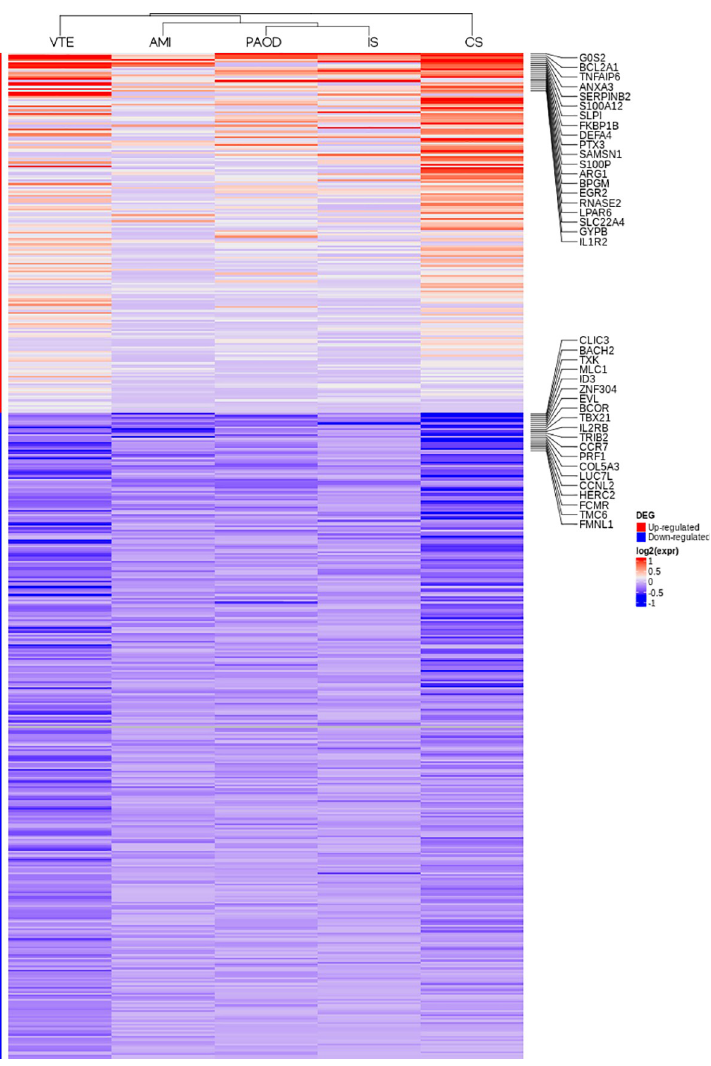
Fig 2. Fold-change of gene expression from patients with venous thromboembolism (VTE). Ischemic stroke (IS). Peripheral arterial occlusive disease (PAOD). Acute myocardial infarction (AMI). Cardioembolic stroke (CS). The top 20 up- (red) and down-regulated (blue) genes are